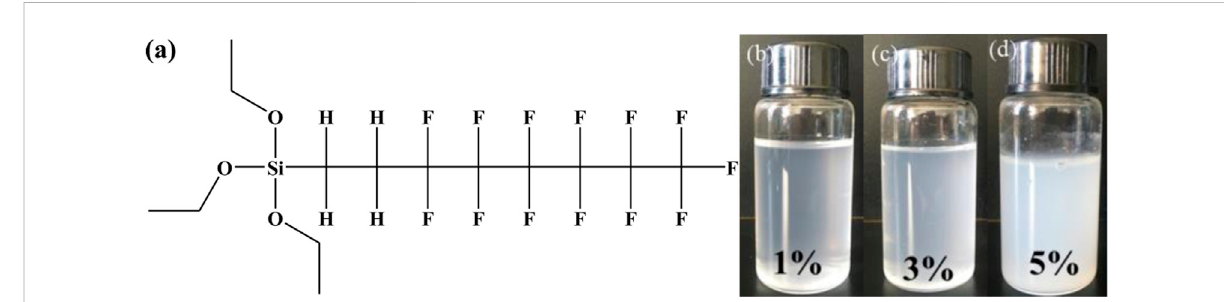
FIGURE 8 Molecular structure of the MSA (A ) and MSA aqueous solution at 1% (B) , 3% (C), and 5% (D) loading.